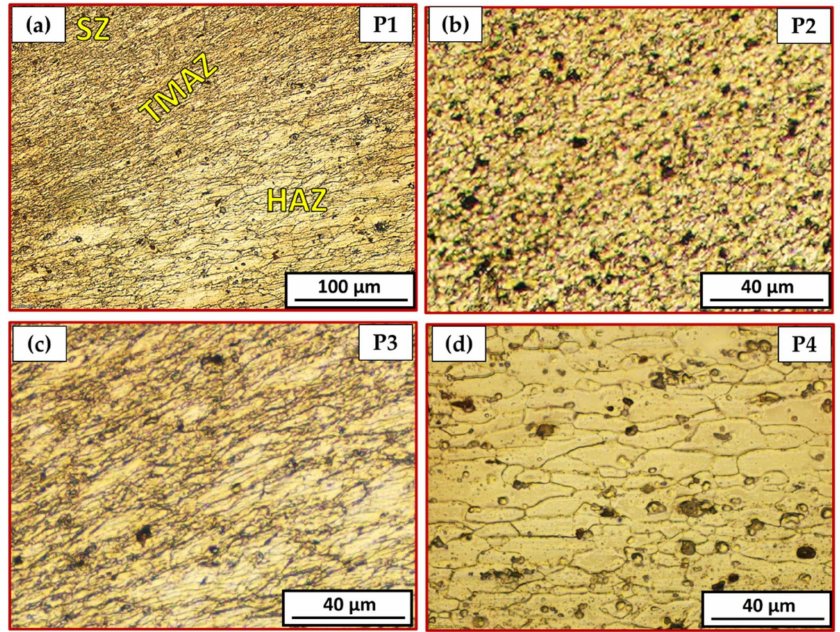
Figure 14. Different microstructure zones of the joint spot welded at 800 rpm where P1 is mixed zone of SZ/TMAZ/HAZ in ( a ), P2 is SZ in ( b ), P3 is TMAZ in ( c ), and P4 is HAZ in ( d